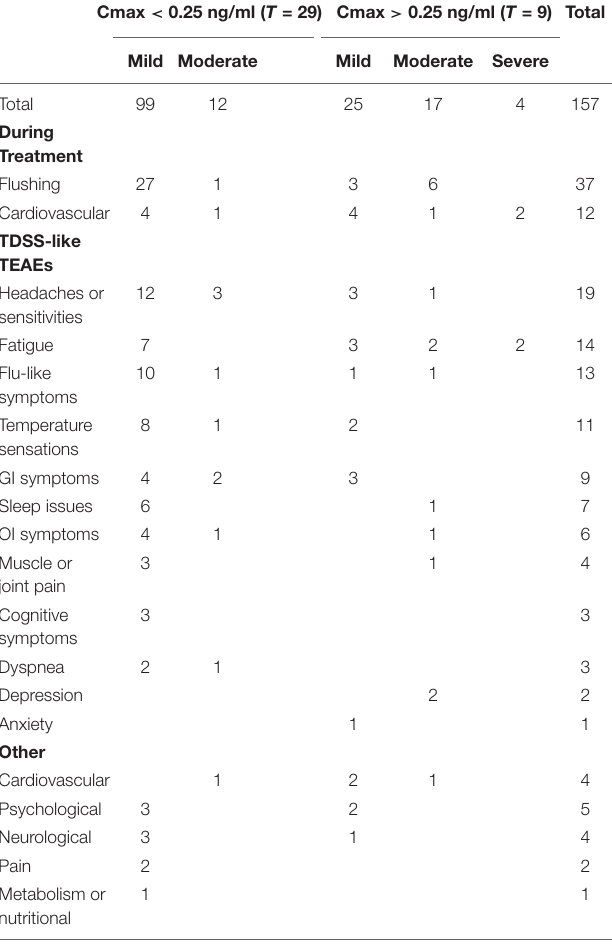
TABLE 3 | Treatment-emergent adverse events, stratified by Cmax.